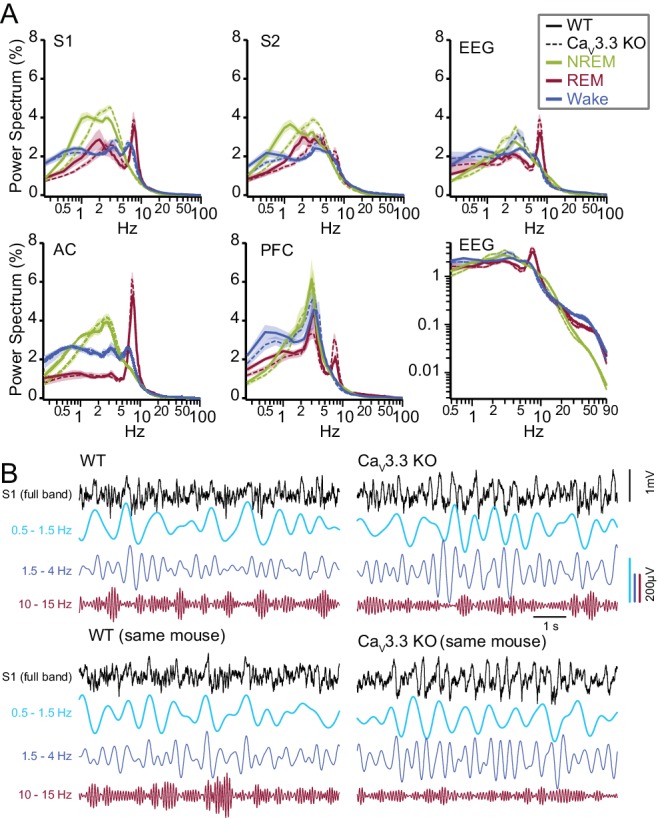
Head-fixed animals present spectra typical for each vigilance state accompanied by distinct LFP waveforms across cortical areas in WT and CaV3.3 KO animals.(A) Power spectra of three main vigilance states (NREMS, REMS and wakefulness) for each local site of recording (LFP), as well as for the EEG, in WT and CaV3.3 KO head-fixed animals. EEG spectra is displayed both in linear-log and log-log scale to distinguish typical differences in low- and high-frequency components of the spectra. (B) Representative S1 traces during NREMS for a WT (left) and a CaV3.3 KO (right) animals, showing (from top to bottom) raw trace, same trace filtered for the SO (0.5–1.5 Hz), delta (1.5–4 Hz), and sigma (10–15 Hz) bands.